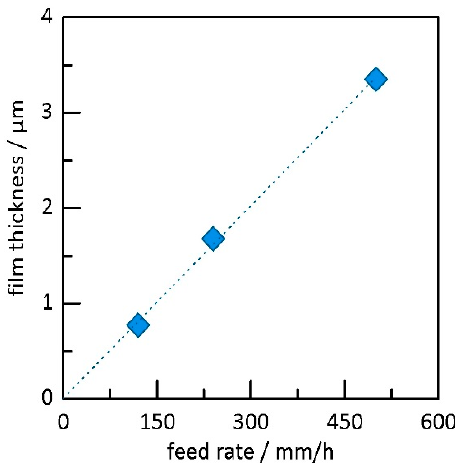
Figure 5. Development of film thickness over powder feed rate for the brush-based generator; the dotted line serves as guide for the eye.